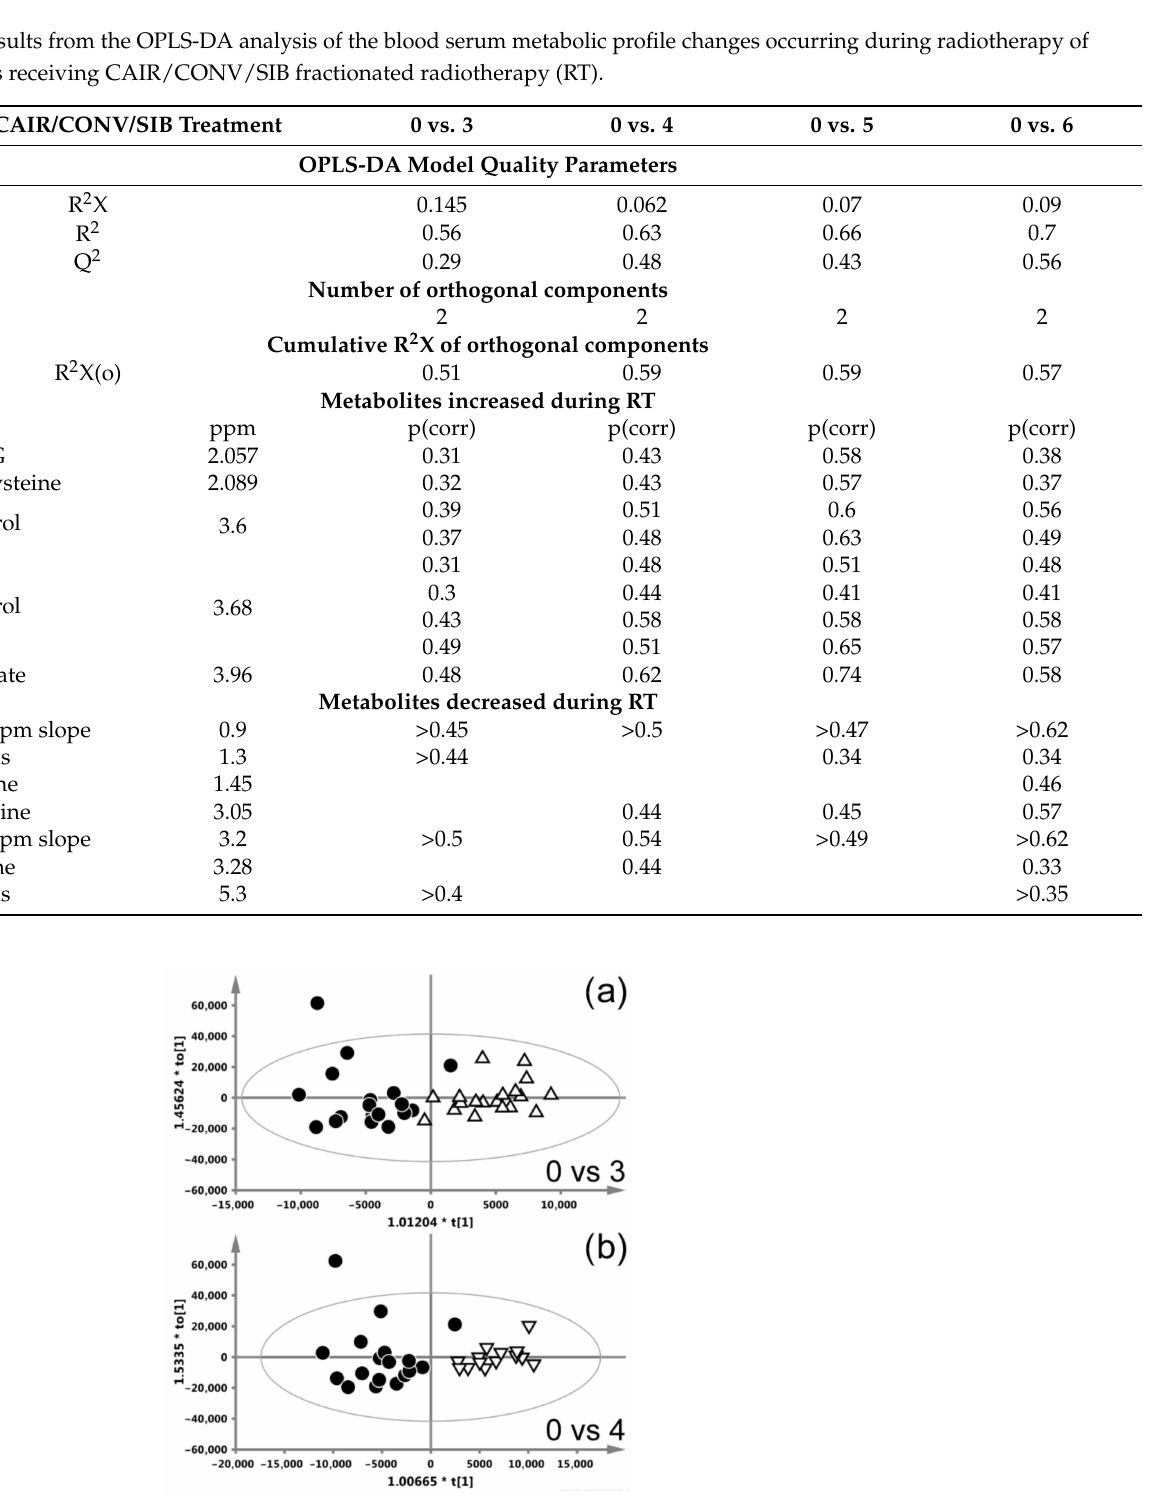
Figure 4. OPLS-DA scores plots differentiating week-0 from the week-3 ( a ) and week-4 ( b ) of radiotherapy (RT) with Manchester fractionation. The models differentiating week-0 from week-1 and week-2 were not